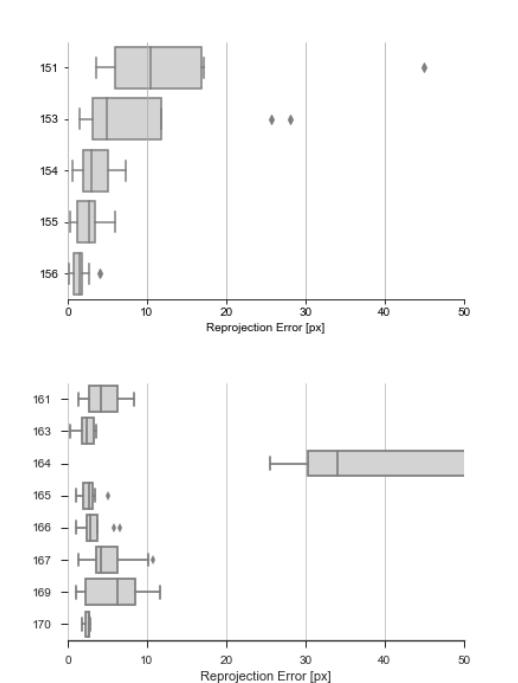
Figure 7. Boxplots of reprojection error for ARCore outdoor series using Helmert transformation (top) and origin method (bottom) respectively